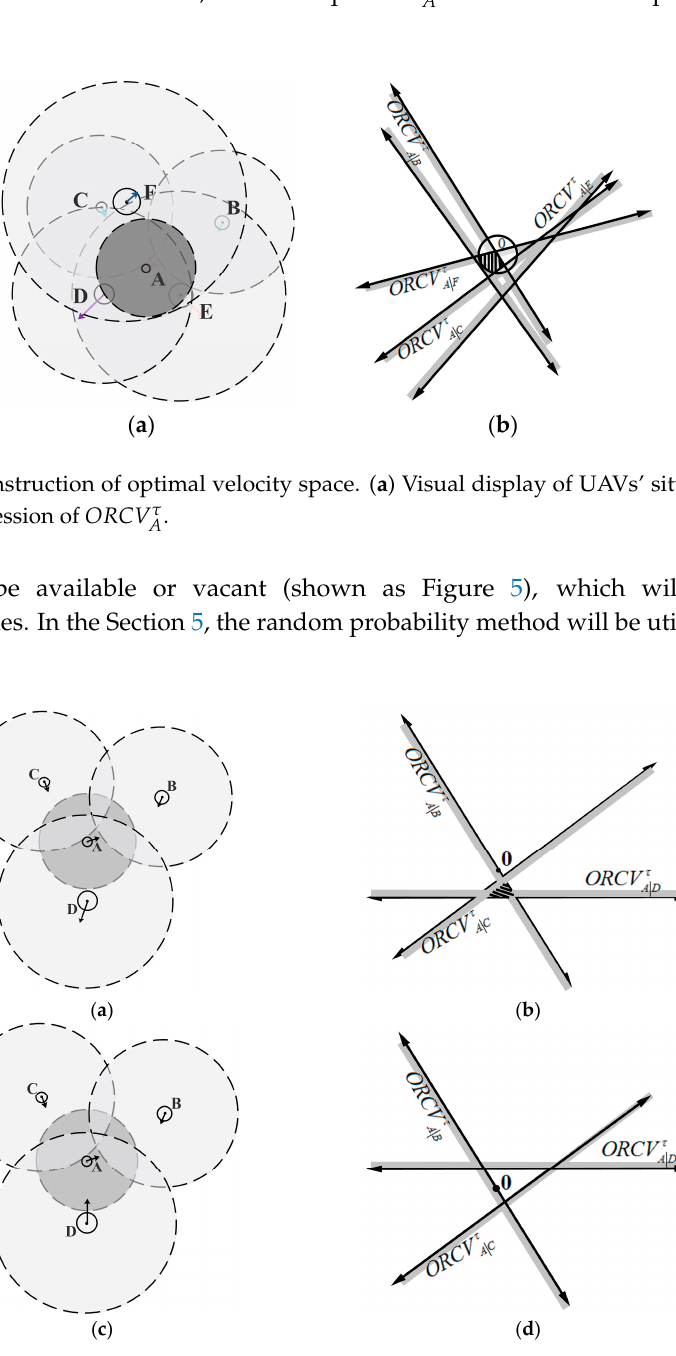
Figure 5. Two situations of optimal velocity space. ( a ) Available situation; ( b ) Available space; ( c ) Vacant situation; ( d ) Vacant space.